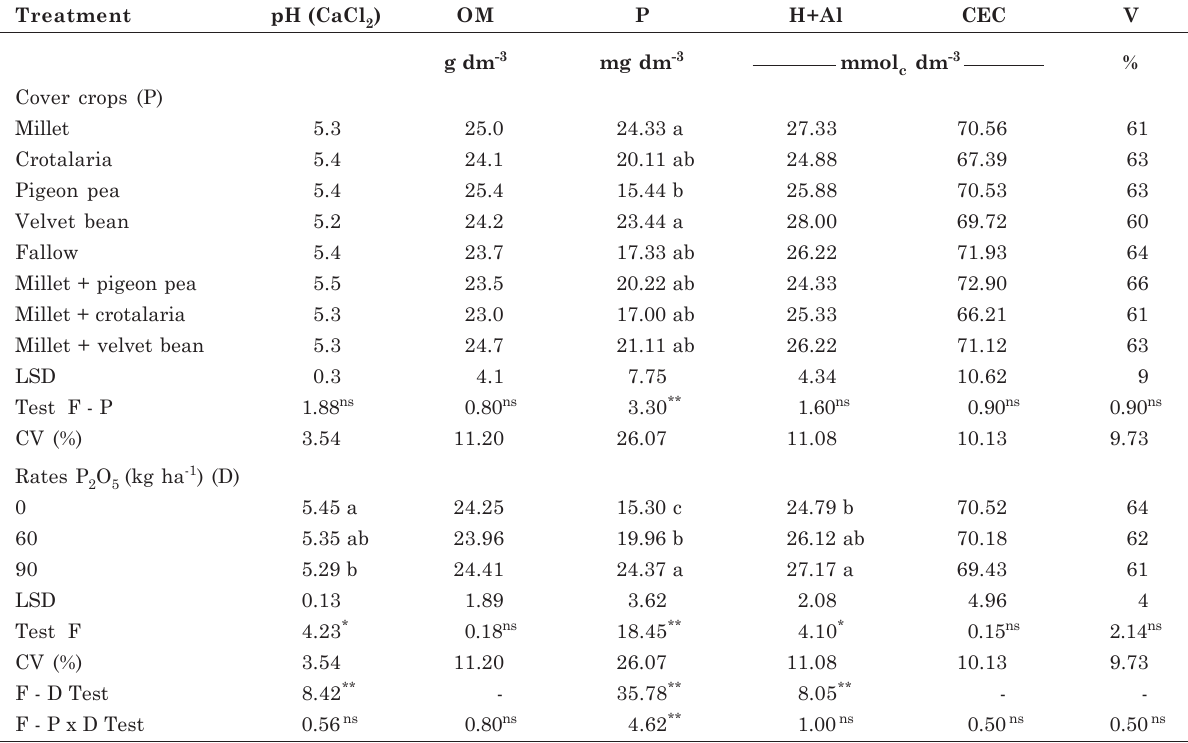
Table 2. Chemical properties evaluated in the 0-0.10 m layer, under different cover crops and rates of P 2 O 5 applied at bean sowing (2010/2011 growing